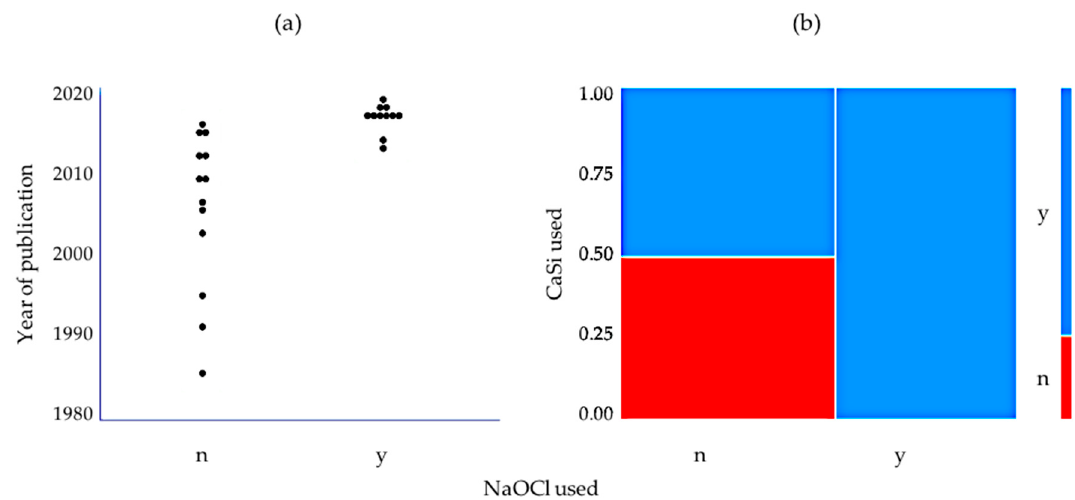
Figure 2. ( a ) Dot plot showing the use of an NaOCl solution in the trials included in this study according to the year of publication. There was a highly significant difference between the mean years of publication (Student’s t -test, p < 0.005). ( b ) Mosaic plot depicting the use of NaOCl for pulp lavage according to the use of calcium silicate cement (CaSi) for pulp capping in the trial (Fisher’s exact test, p < 0.05).